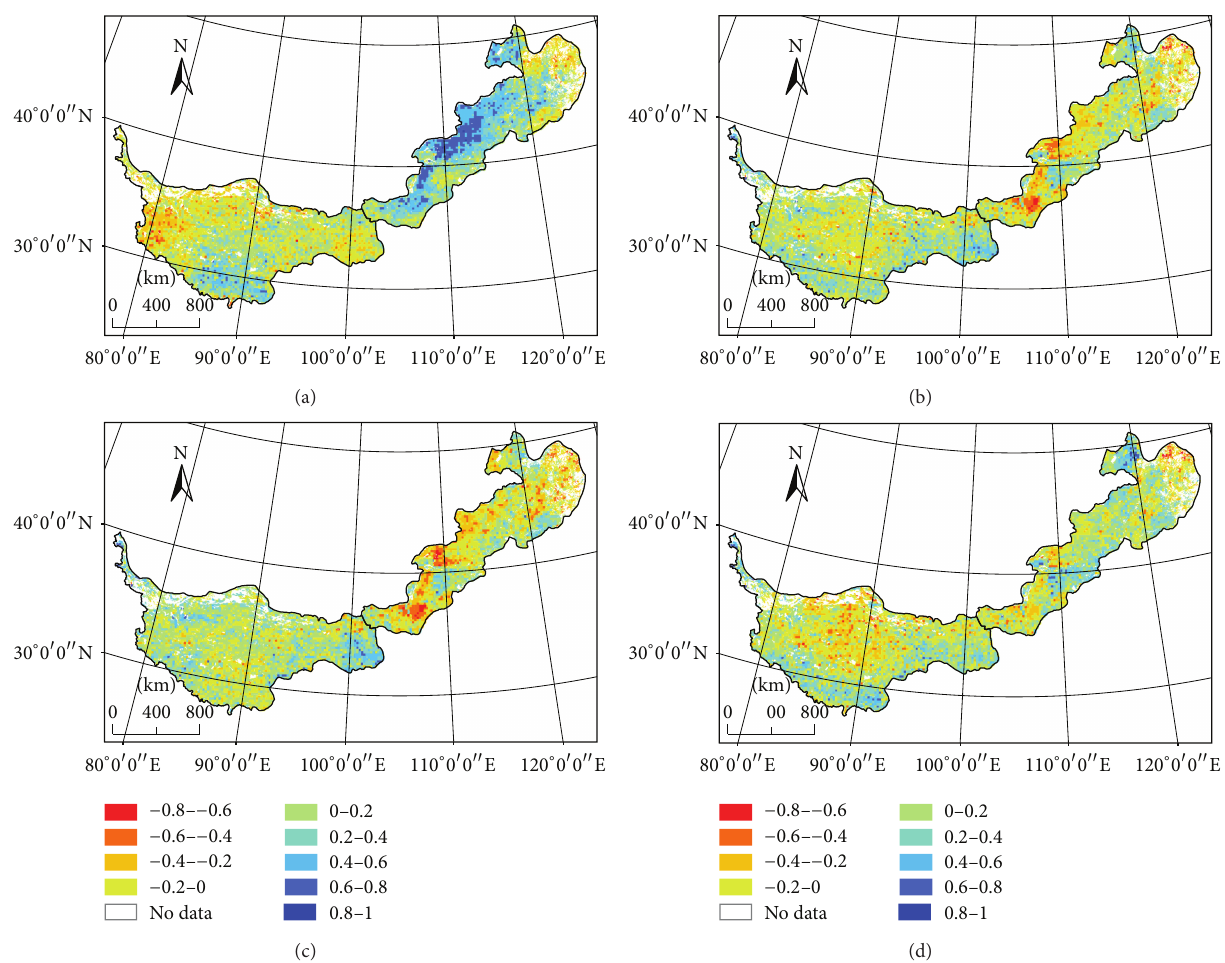
Figure 3: Spatial distributions of correlation coefficients between the growing season NDVI and growing season (a) precipitation, (b) 𝑇 mean , (c) 𝑇 max , and (d) 𝑇 min for period 1982–2006.